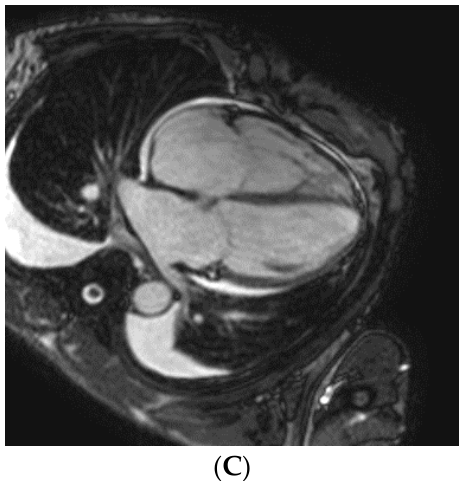
Figure 1. ECG, echocardiography and CMR images of patients without increased wall thickness and CA. ( A ): ECG: sinus rhythm, first degree AV block, no low voltage, ST-T changes. ( B ): Echocardiography. End diastolic frame, parasternal long axis view. ( C ): CMR image. Long axis four chamber view from a steady-state free precession movie sequence. End diastolic image. Normal left ventricular wall thickness and bilateral pleural effusion. ( D ): Late gadolinium enhancement from a phase sensitive inversion recovery (PSIR) sequence from the same patient in short axis view. Diffuse subendocardial enhancement, typical for CA.